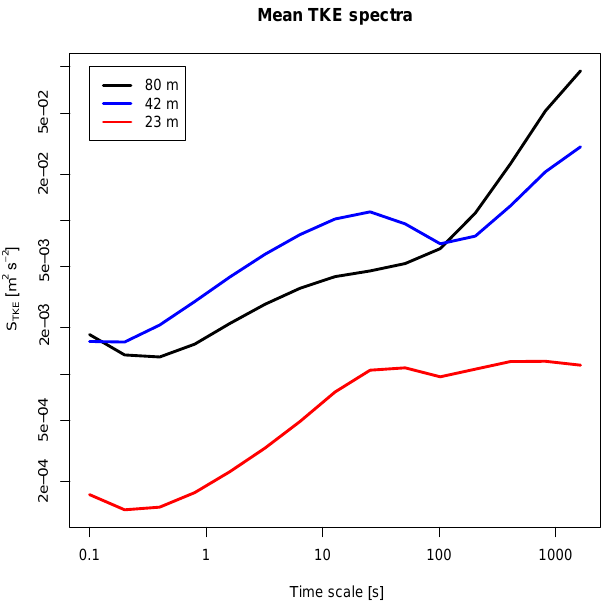
Figure 14. Upper panel: multi-resolution 42m vertical velocity spectra for the night of 4 May 2012 (colors and contours), and mean wind difference between the 80 and 42m levels (red line, scale at the right side). Lower panel: temporal evolution of vertical velocity at the 42m level for the same